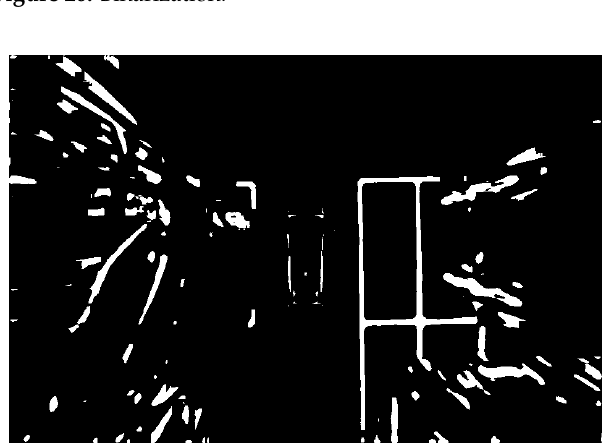
Figure 20. Binarization.